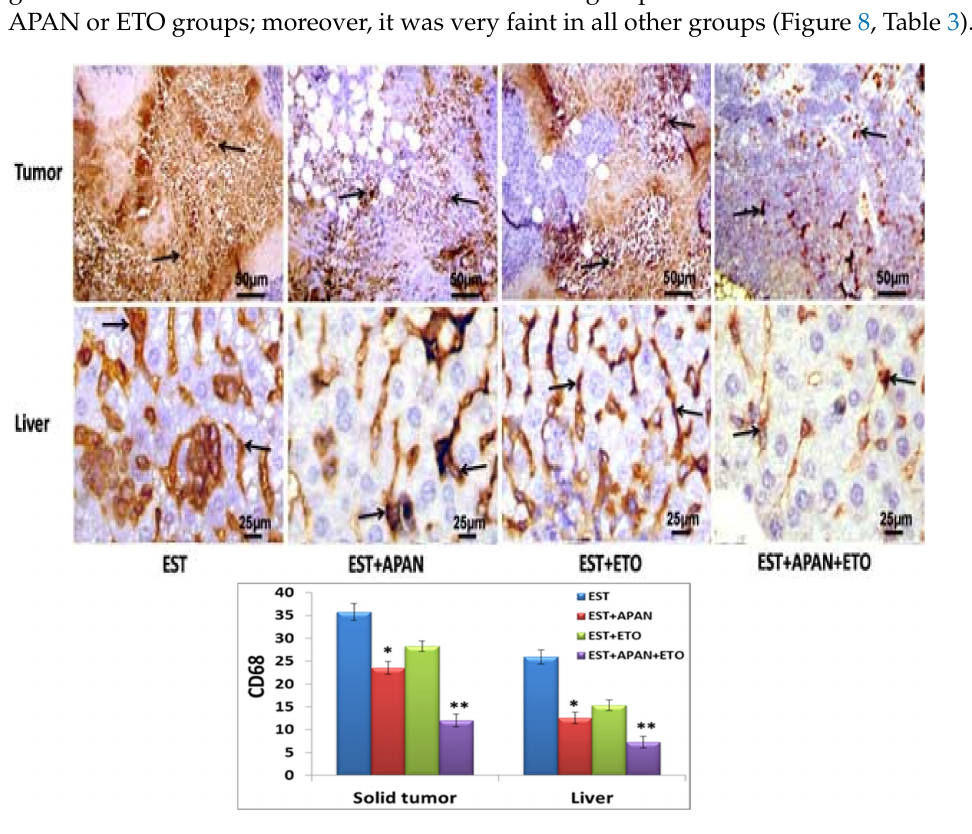
Figure 8. Photomicrographs and chart of CD68 immunohistochemical expression (arrows) of Ehrlich solid tumor-bearing mice (EST) after mono (EST+APAN or EST+ETO) and dual treatment (EST+APAN+ETO). Scale bar of solid tumor = 50 µ m and liver = 25 µ m, (*) indicates significantly different, (**) indicates the maximum decrease ratio compared to the EST group, and p <